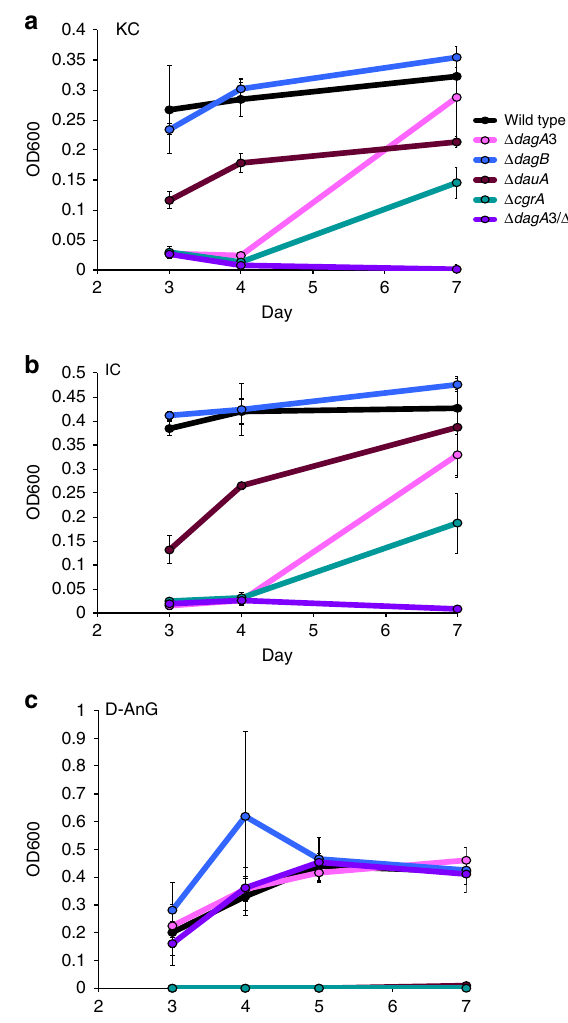
Fig. 6 Average growth of wild-type Z. galactanivorans and deletion mutants. Growth on a kappa-carrageenan, b iota-carrageenan and c 3,6-anhydro- D - galactose (D-AnG) as sole carbon source over a 7-day period. Error bars represent standard error of the mean between three replicates.